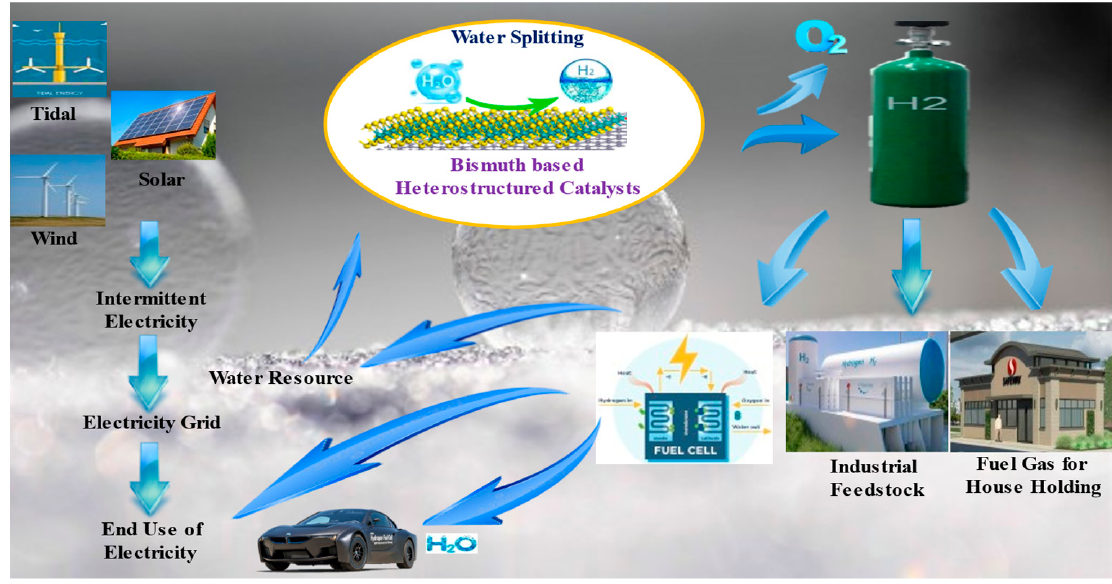
Figure 16. Schematic representation of future perspectives for hydrogen energy.